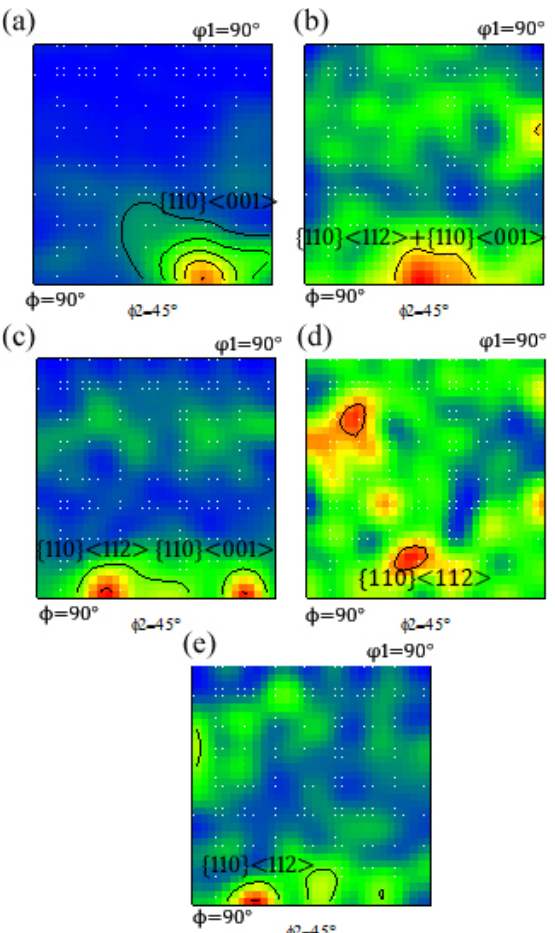
Figure 12. The orientation distribution function (ODF) of Ni-36.6W-15Co in ( a ) rolled, and after annealing for ( b ) 10 min, ( c ) 30 min, ( d ) 60 min and ( e ) 120 min at 1150 °C.